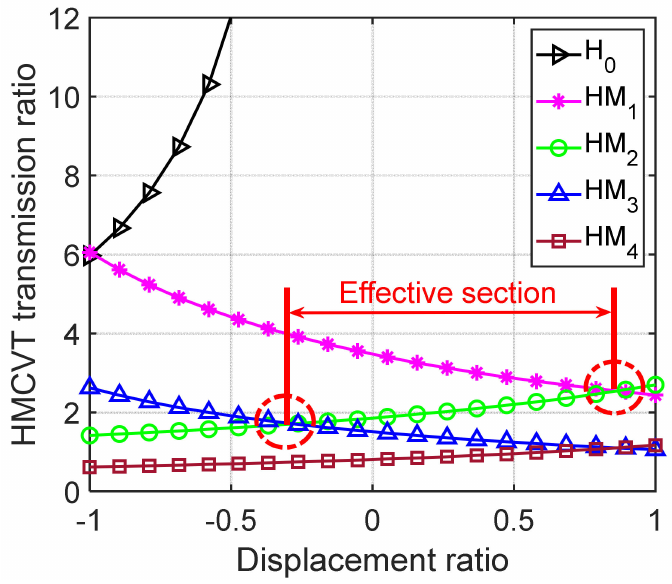
Figure 3. The transmission ratio characteristic and effective section of each working